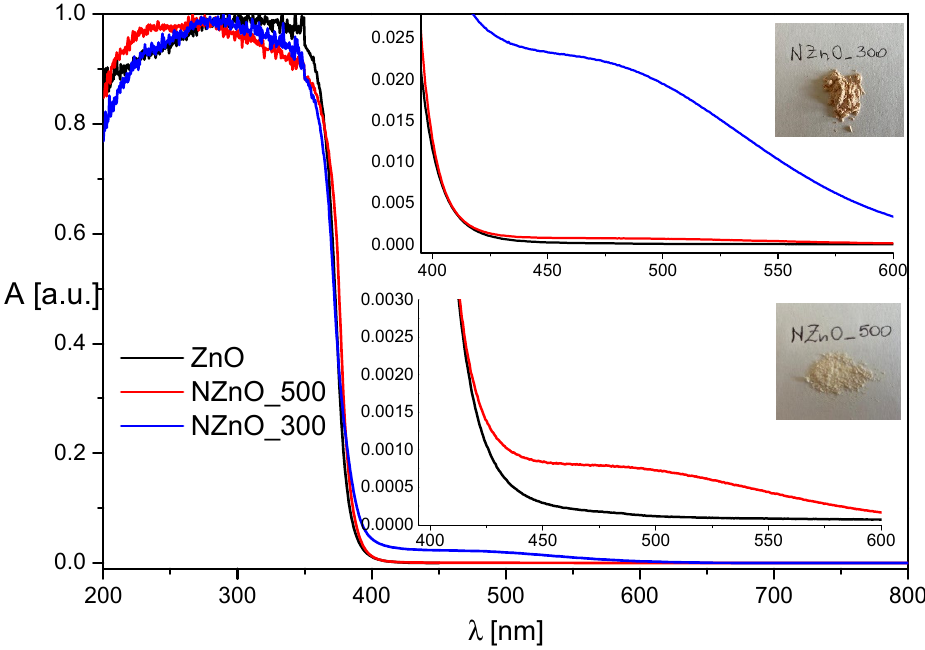
Figure 2. DR-UV-Vis spectra (Kubelka-Munk) of ZnO (black); NZnO_500 (red), NZnO_300 °C (blue) samples. The y-axis reports the absorbance (A) in arbitrary units.